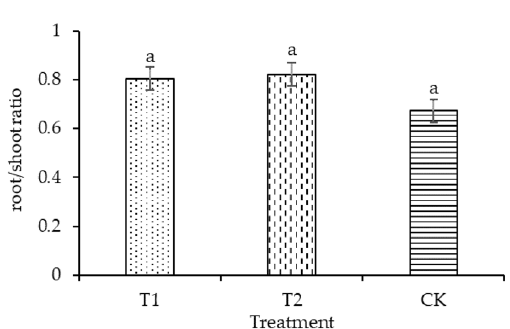
Figure 8. Root/shoot ratio of seedling under different